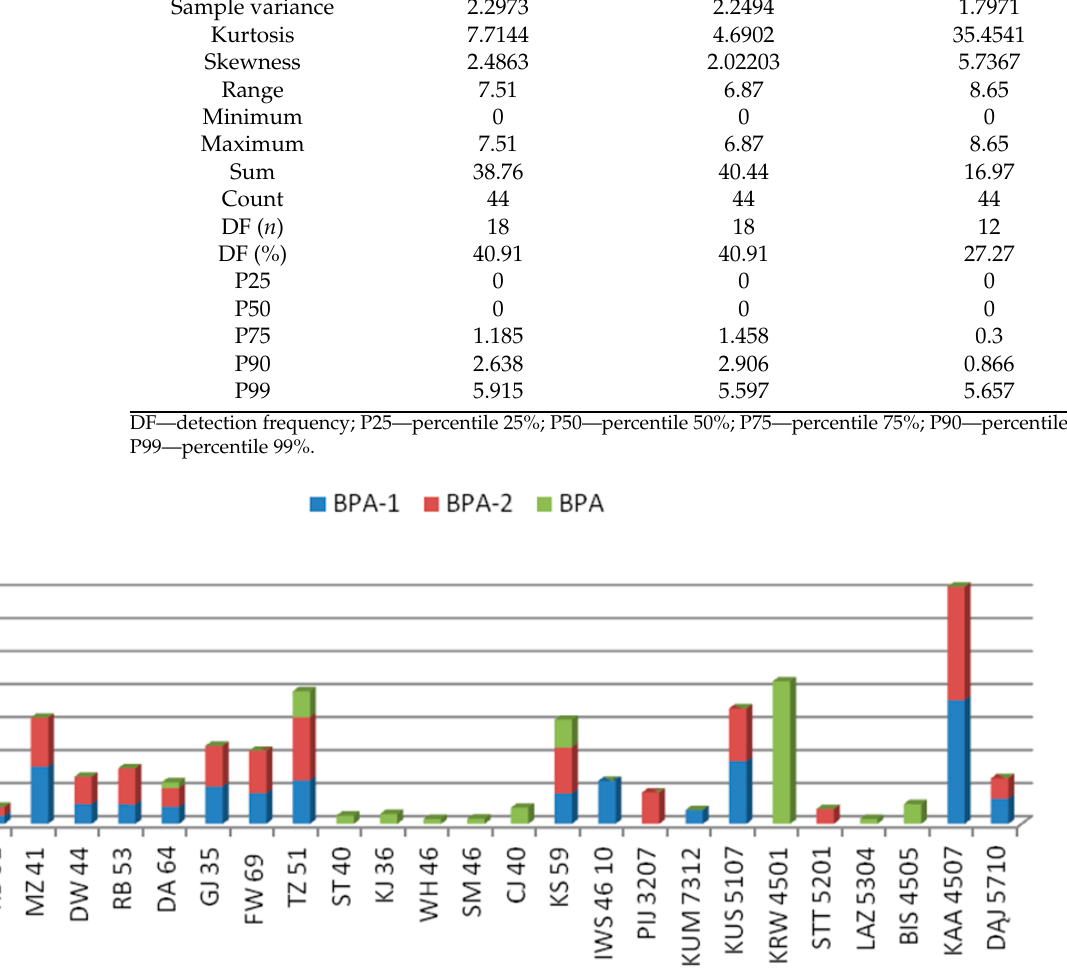
Figure 4. UHPLC–MS/MS chromatogram of AH samples with detected BPA ( a ), AH sample with